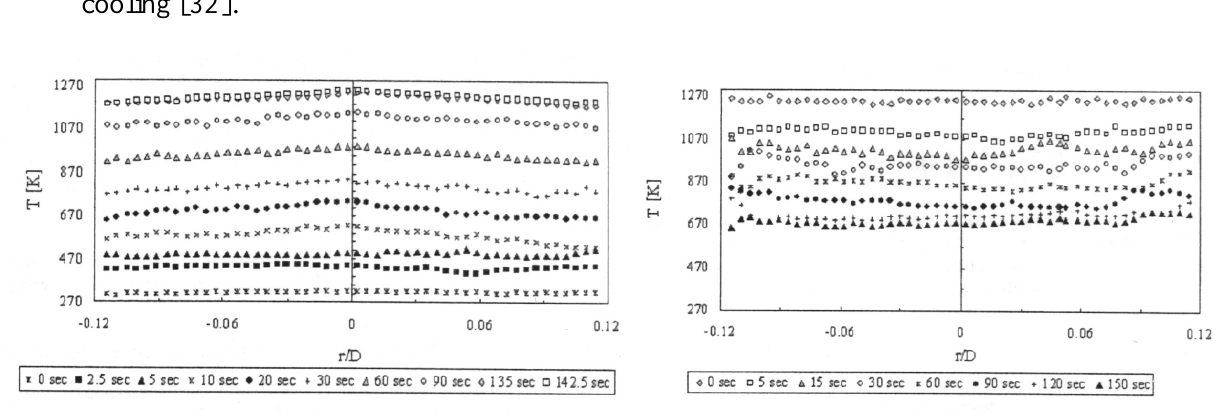
Figure 41. Centre region radial temperature profiles during a) jet impingement; b) cooling